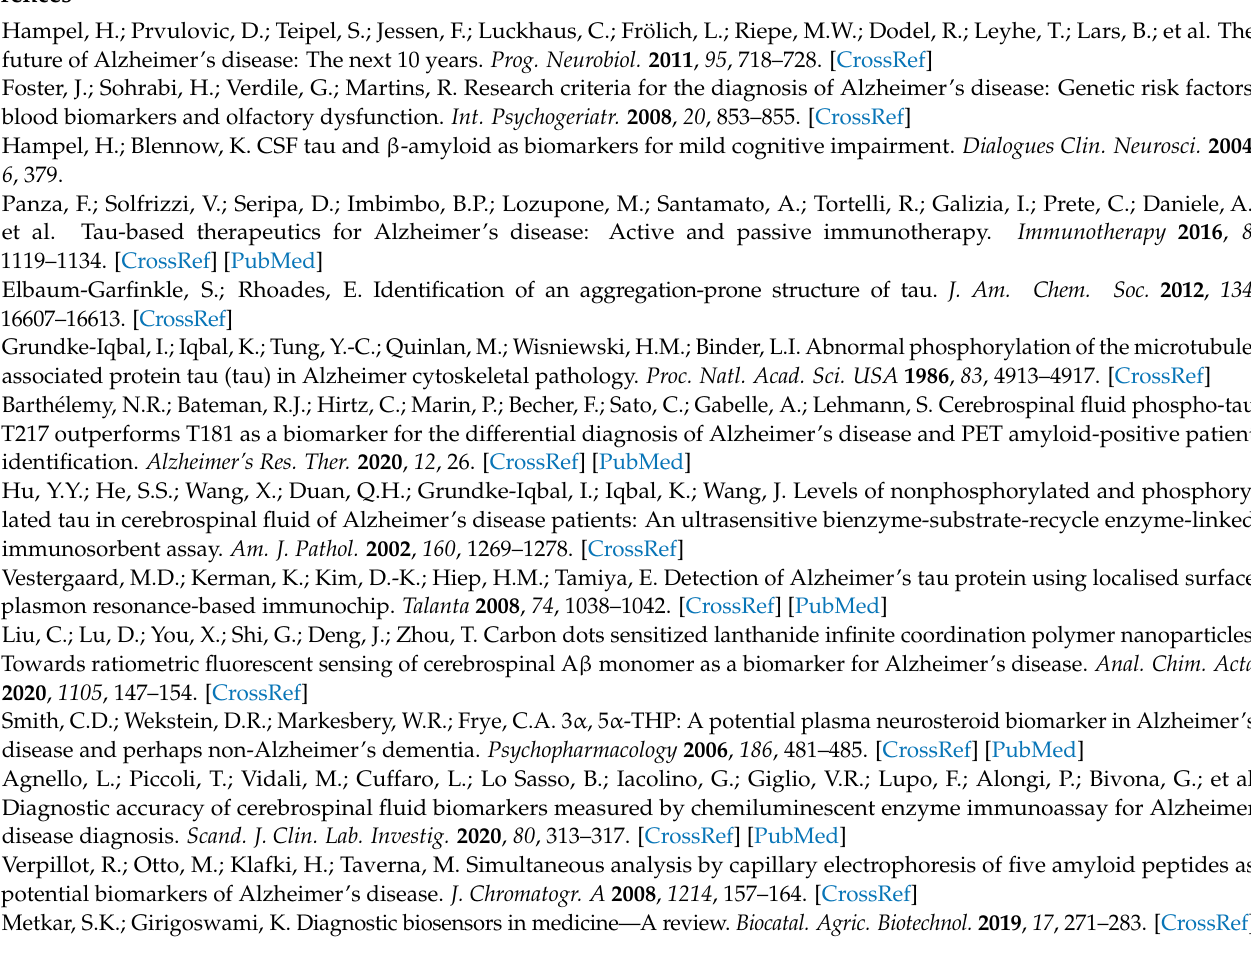
Figure S4: SEM images of the C-SPE, MIP and NIP materials; Figure S5: Reproducibility study of the